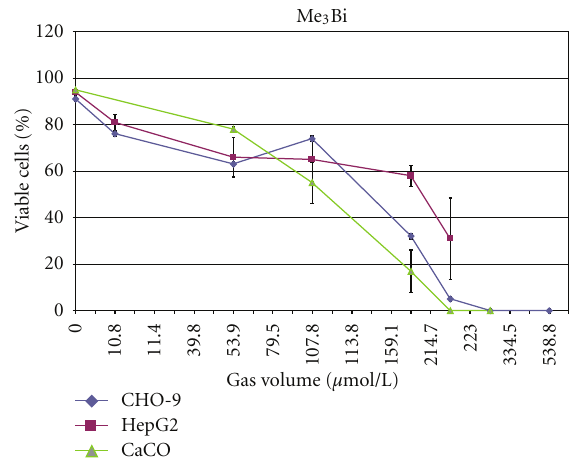
Figure 6: Cytotoxicity of Me 3 Bi in CHO-9, HepG2, and CaCo cells. The experiments were repeated three